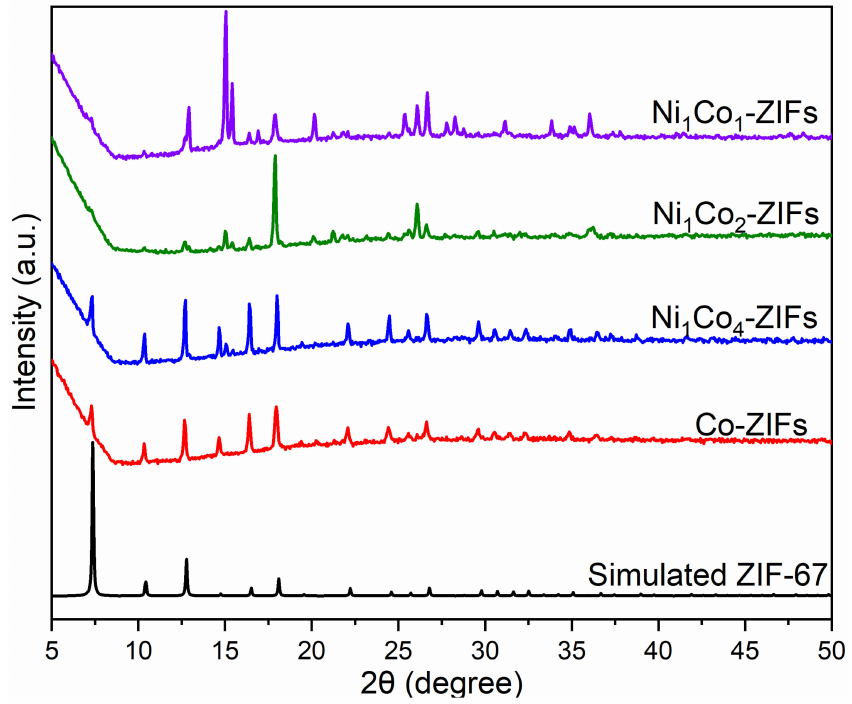
Figure 2. The XRD patterns of different Ni x Co y -ZIFs crystals: Ni 1 Co 1 -ZIFs; Ni 1 Co 2 -ZIFs; Ni 1 Co 4 - ZIFs, and Co-ZIFs.